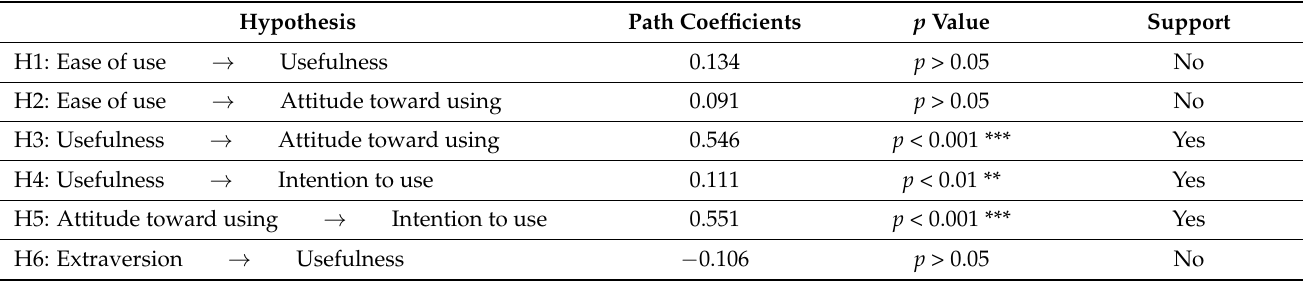
Table 5. Model path